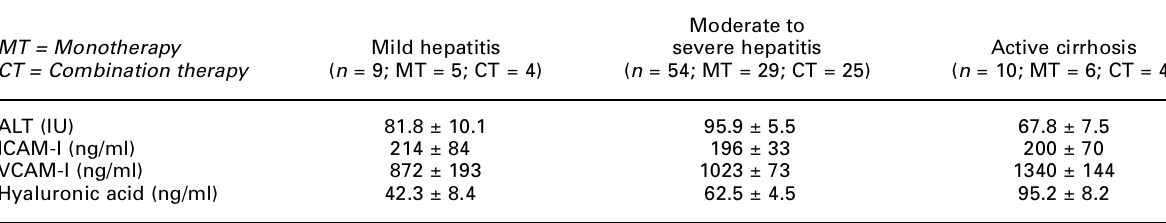
Table 2. Fibrosis scoring versu ALT, ICAM-I, VCAM-I and hyaluronic acid